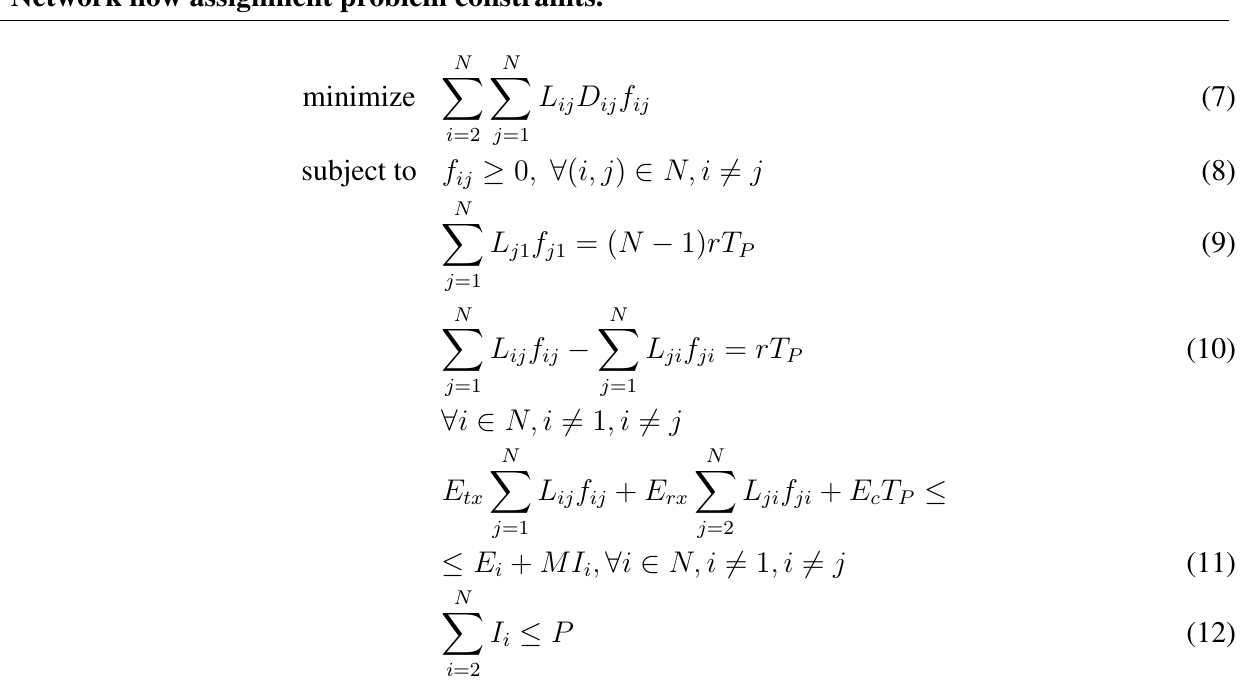
Table 3. Flow assignment